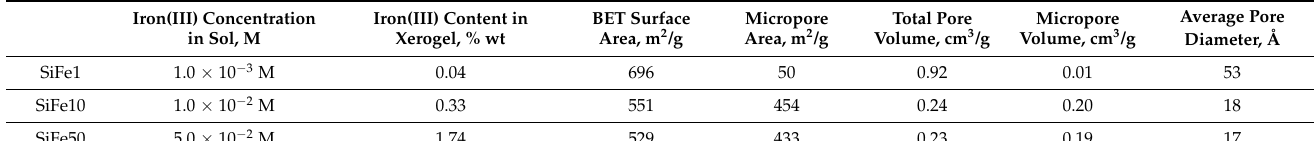
Table 1. Comparison of textural characteristics of silica xerogels doped with iron(III).